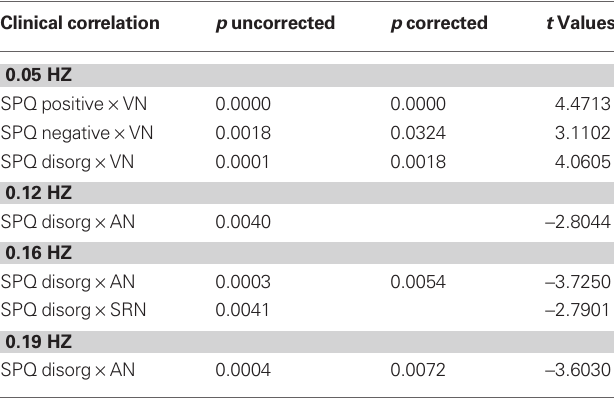
Table 8 | Statistical results for correlation between SPQ measures and RSN frequency